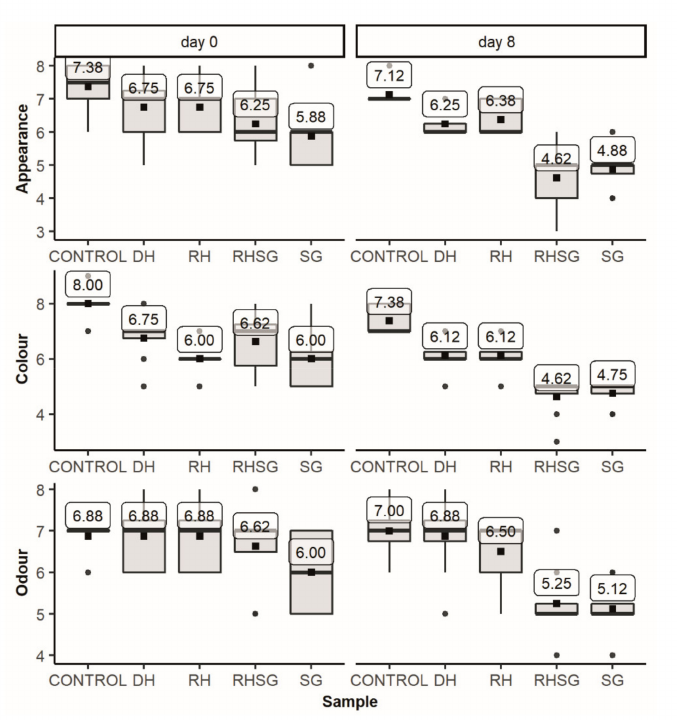
Figure 3. Sensory characteristics of raw pork patties with different plant-based ingredients on storage days 0 and 8 on the 9-point hedonic scale (control—without additives, RH—with 2% dried mechani- cally pressed hempseed cake, DH—with 2% defatted by supercritical CO 2 extraction hempseed cake, RHSG—with 0.5% sweet grass extract and 1.5% dried pressed hemp seedcake, and SG—0.5% sweet grass